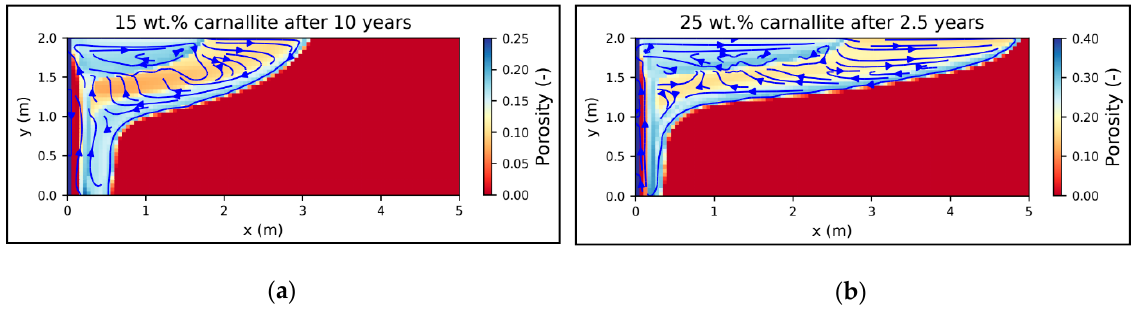
Figure 15. Porosity distribution in an initially transport- and advection-dominated system, in the long run diffusion-dominated (dissolution rate 10 − 3 cm/s, carnallite content ( a ) 15 wt.% and ( b ) 25 wt.%).